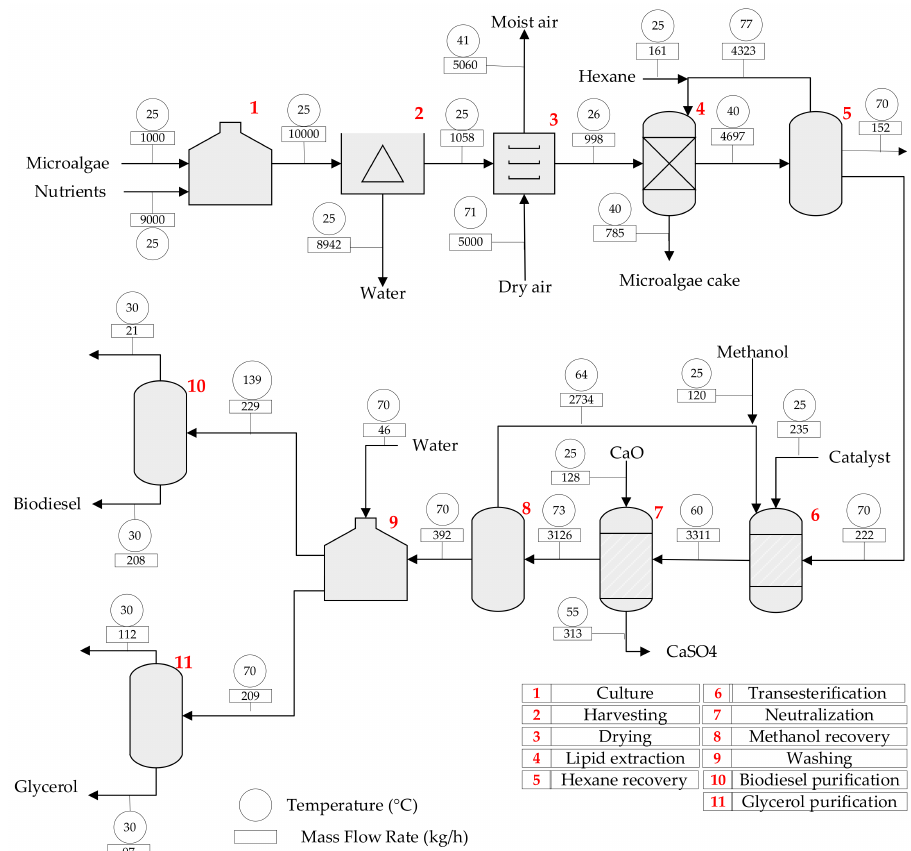
Figure 2. Process diagram for biodiesel production from microalgae via lipid extraction and